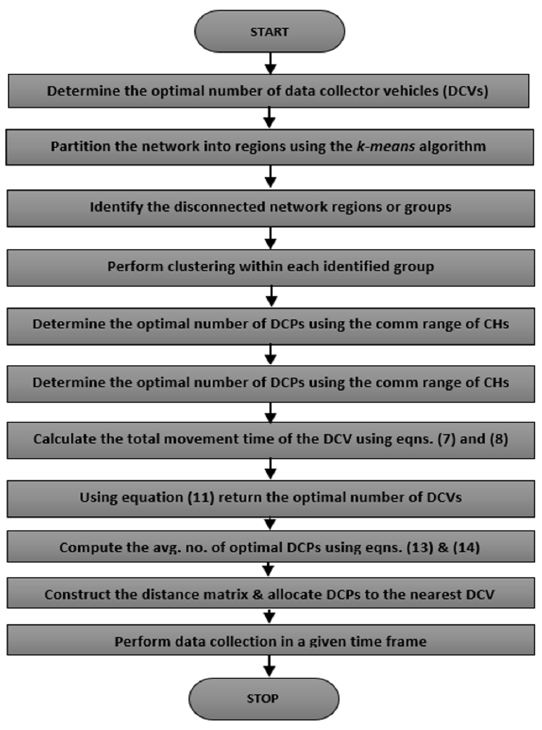
Figure 7. Flow chart of the proposed approach.